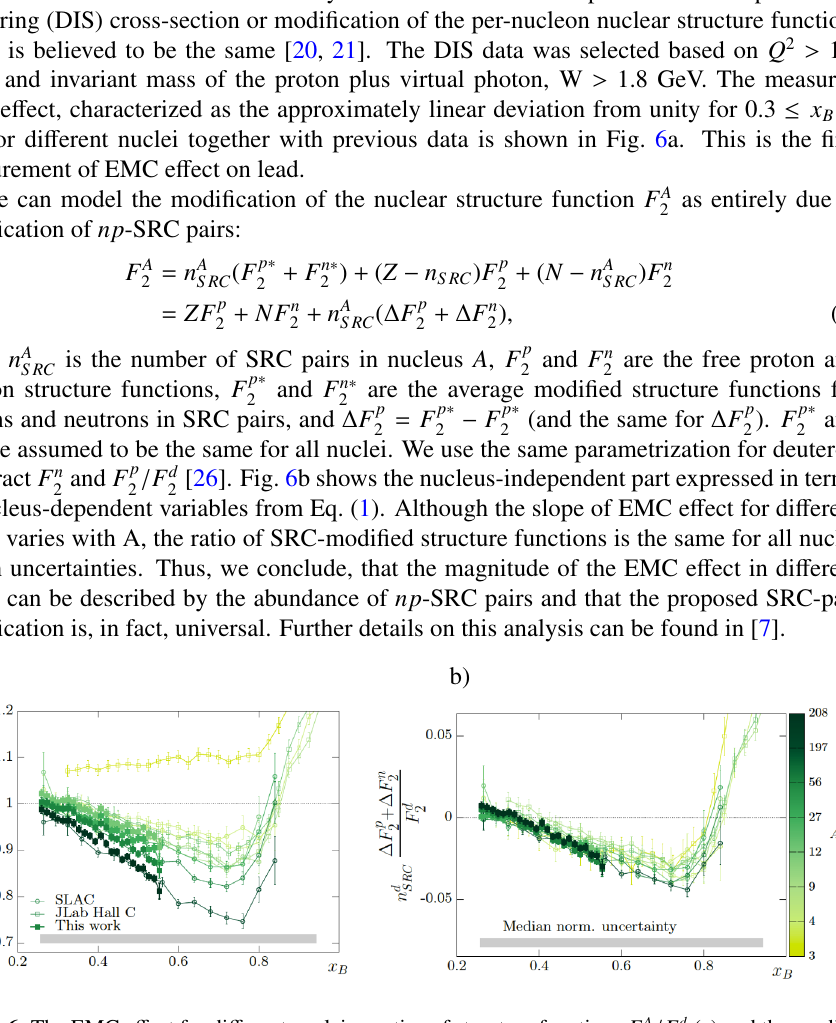
/ F d (a) and the modifi- 2 2